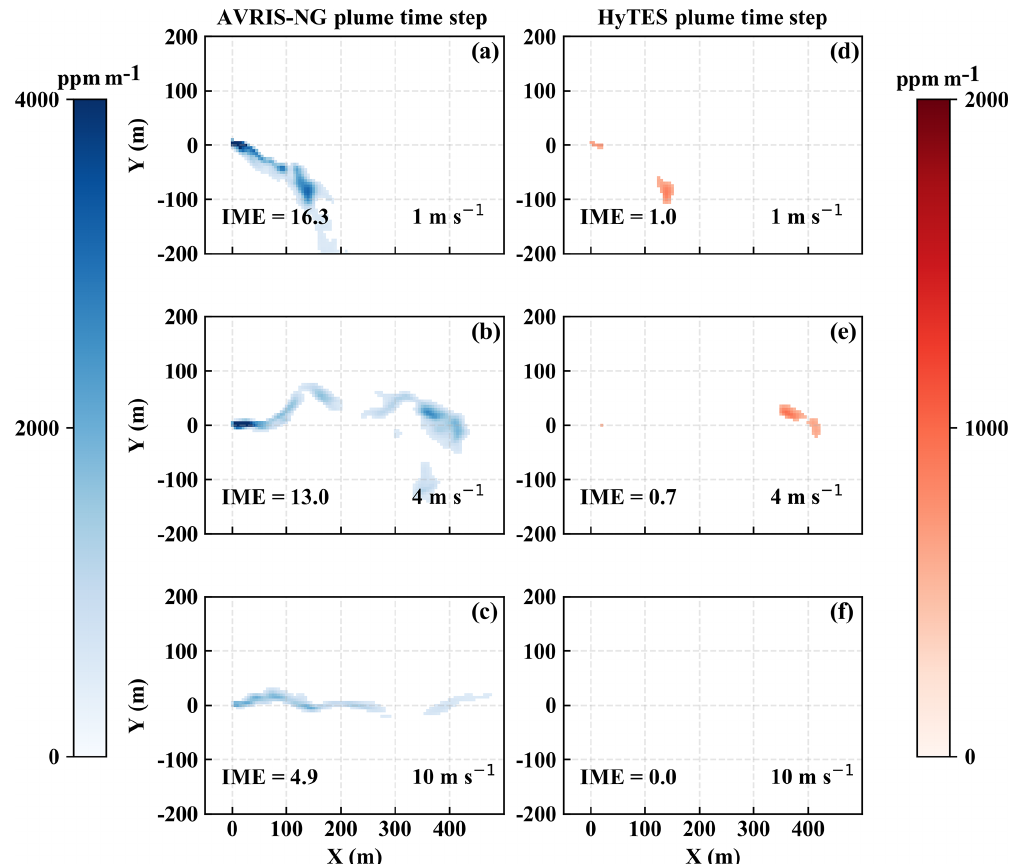
Figure 5. (a–c) Snapshots from simulated plumes under 1, 4, and 10ms − 1 respectively, when applying the AVIRIS-NG instrument column averaging kernel. (d–f) Snapshots from the exact same plumes as in (a–c) respectively but applying the HyTES averaging kernel. The flux rates are all 300kgh − 1 and the detection threshold is set to 500ppmm − 1 . The IME is in